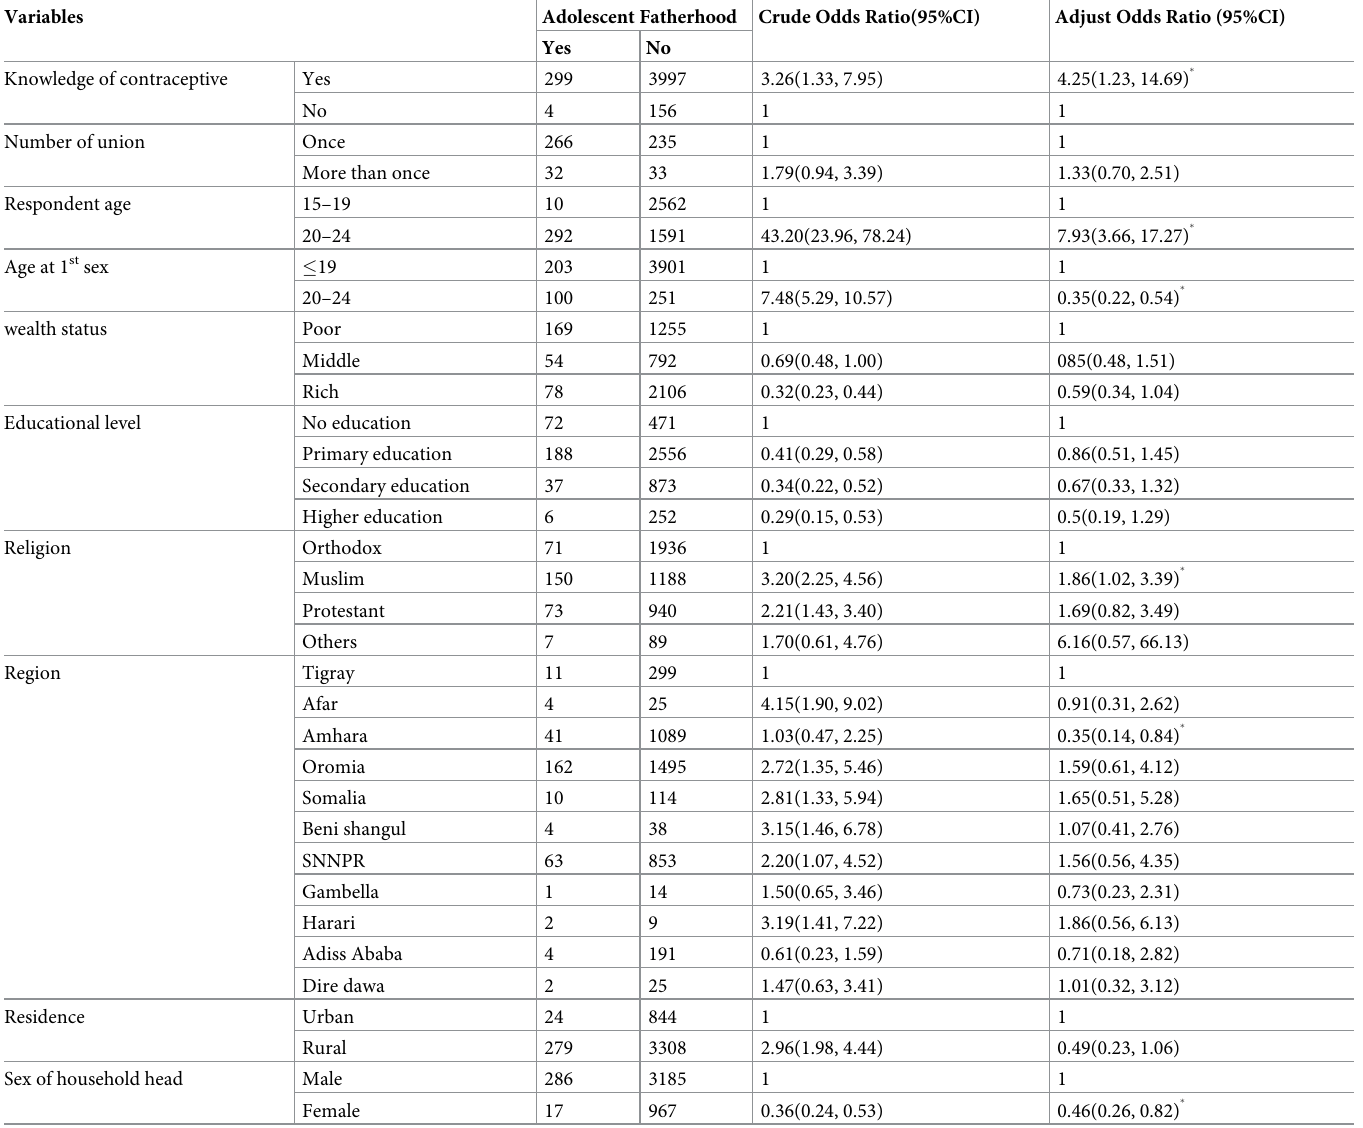
Table 4. Multilevel analysis for the assessment of determinants of adolescent fatherhood in Ethiopia,